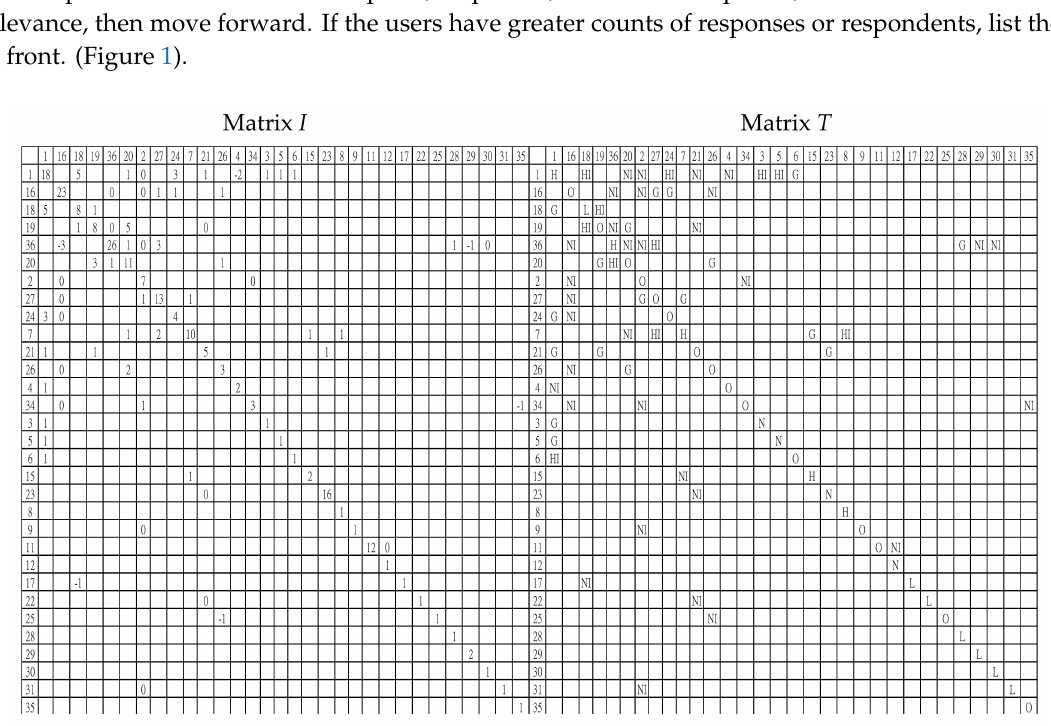
Figure 1. Matrix element conversion. Note1: the criterion of influence power: NI = no